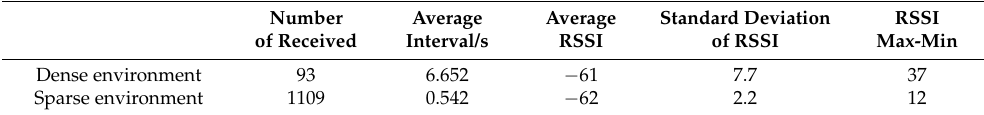
Table 1. RSSI value and the scanning time interval of the BLE.